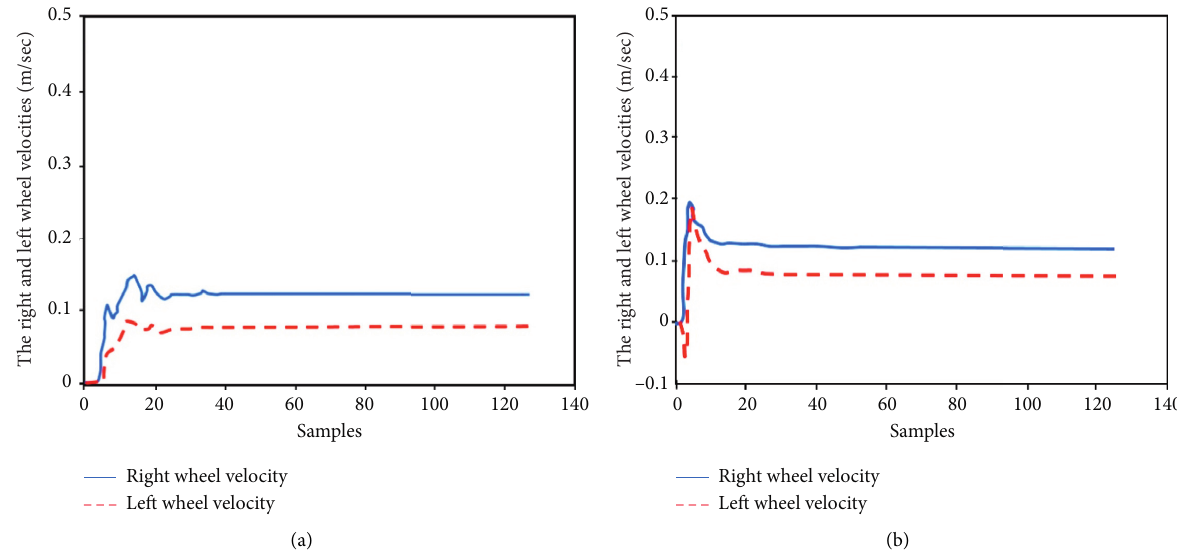
Figure 8: The left and right wheels’ velocity of DDMR for circular trajectory tracking adopting 0.5 ∗ MSE+0.5 ∗ ( U 12 + U 22) index. (a) The left and right wheels with NNFOPID and (b) the left and right wheels with NNPID.